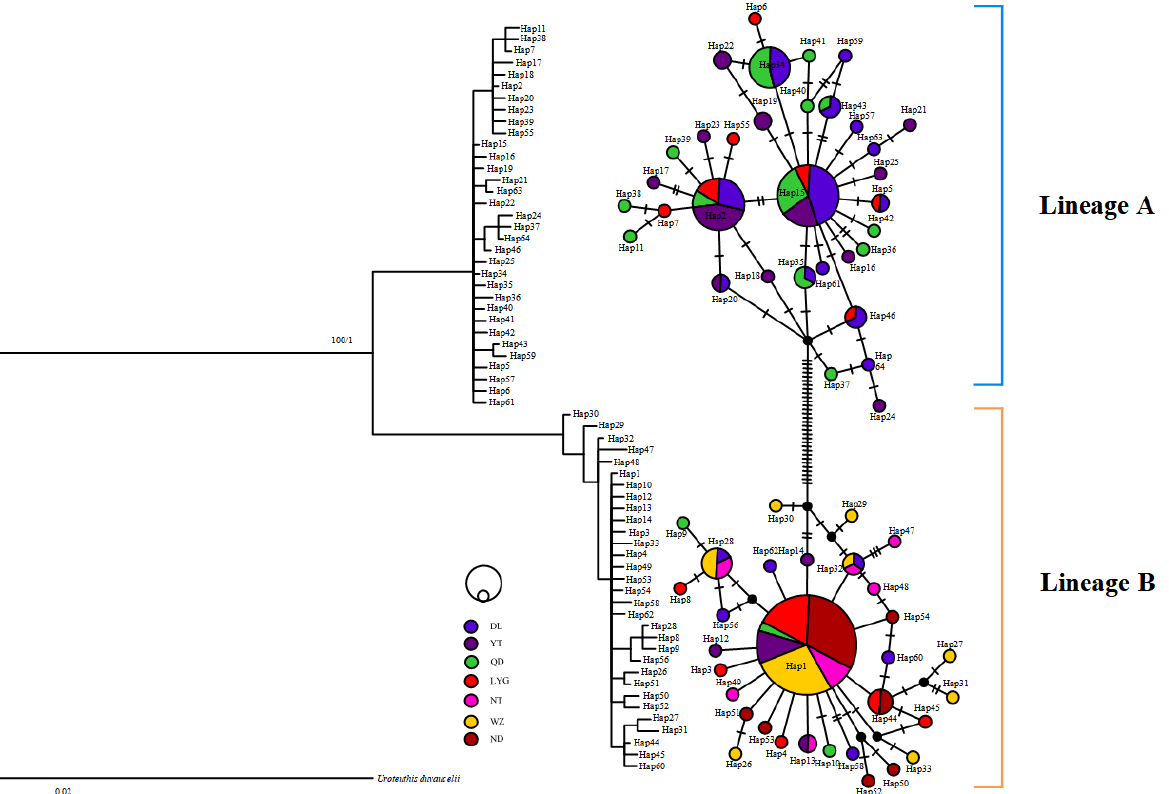
Figure 2. Maximum likelihood (ML) and Bayesian inference (BI) phylogenetic tree and haplotype network of L. ( N. ) beka based on COI haplotypes. Size of circle is proportional to the frequency of a particular haplotype. Each small line on the line that connects two circles represents a mutational step, and black dots represent hypothetical missing intermediates.